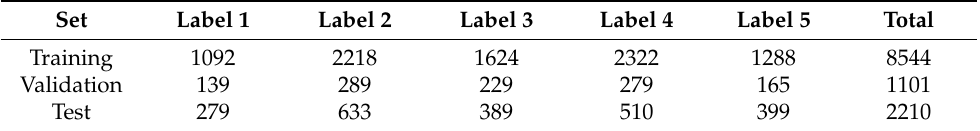
Table 3. SST-5 label